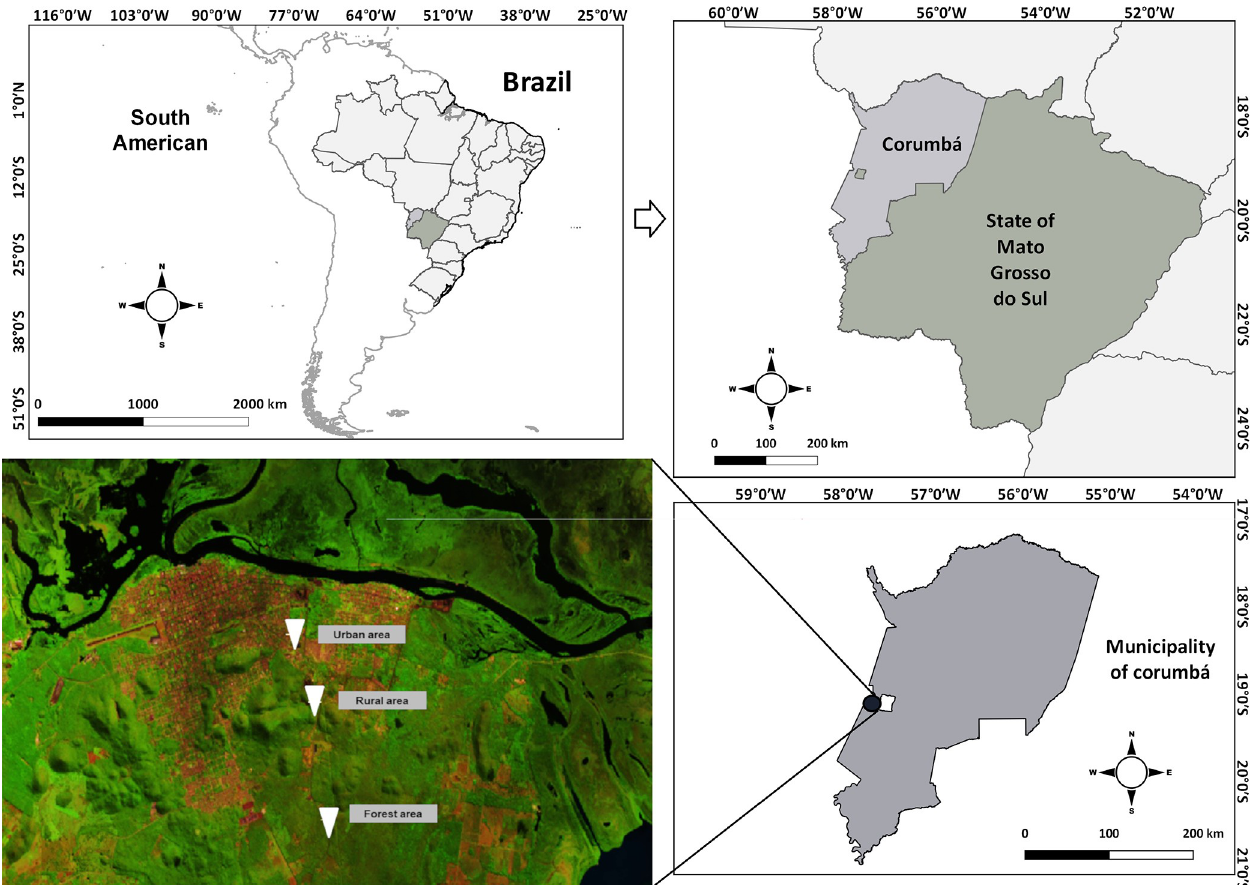
Fig 1. Location of the study area, with county limits and urban area of Corumba´, Mato Grosso do Sul, Brazil. White dots represent transect. The urban area of the municipality of Corumba´ is represented by a Landsat 8, OLI, Band 4, 5 and 6. Earth Explorer Path 227 row 73 composition RGB 654 (26/05/2015). Note: the map of Brazil (and the shapefile used to generate it) used for the elaboration of Fig 1 was extracted from the database of public domain of the Brazilian Institute of Geography and Statistics (https://downloads.ibge.gov.br/downloads_top.php) and U.S. Geological Survey (http://viewer.nationalmap.gov/viewer/).